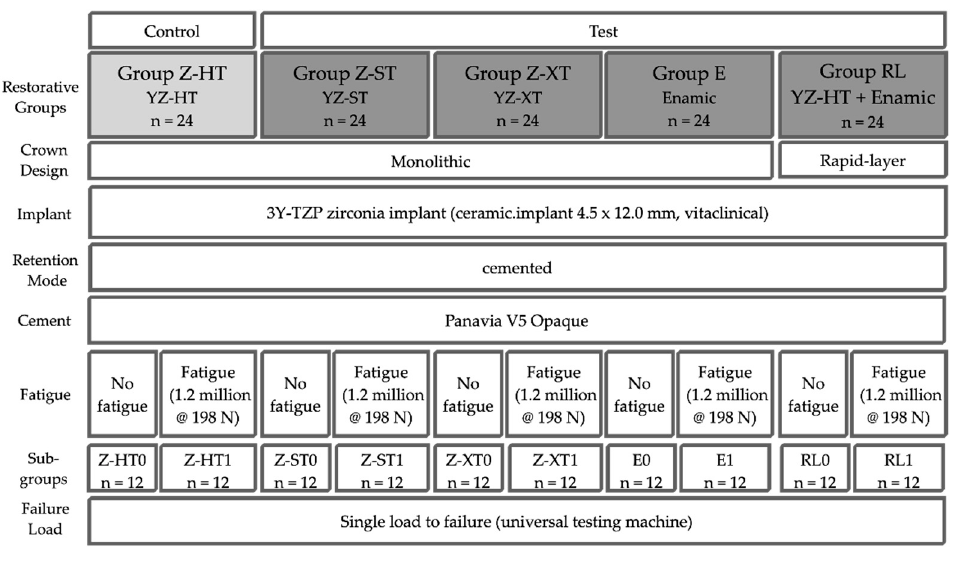
Figure 1. Study set-up. Table 1. Restorative materials with group codes and investigated implant with characteristic flexural strength according to manufacturer.